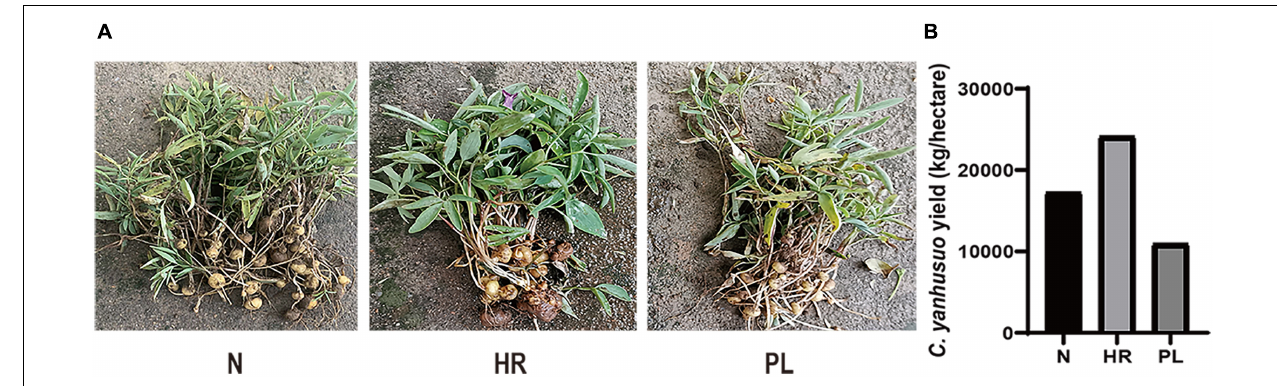
FIGURE 1 | The effect of different field types upon the Corydalis yanhusuo tuber yield. (A) Photographs of C. yanhusuo plants from the three different fields. (B) The total tuber yield per hectare of C. yanhusuo tuber from each field type. PL, plants from the PL field (field under peanut– C. yanhusuo rotation); N, plants from the N field ( C. yanhusuo field without rotation and flooding); HR, plants from the HR field ( C. yanhusuo field that had been flooded in July, 2020). TABLE 1 | Physicochemical properties of soils from three different cultivation fields of C. yanhusuo in the Xuyi District, eastern China.